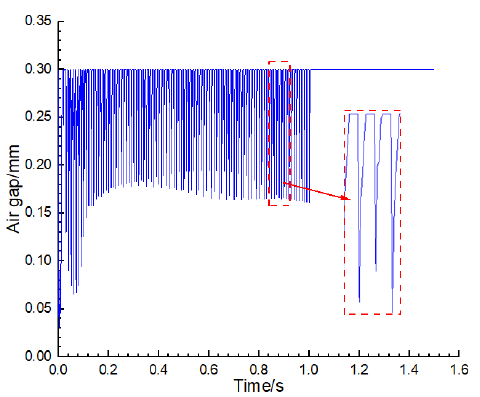
Figure 17. Air gap distance curve of No.1